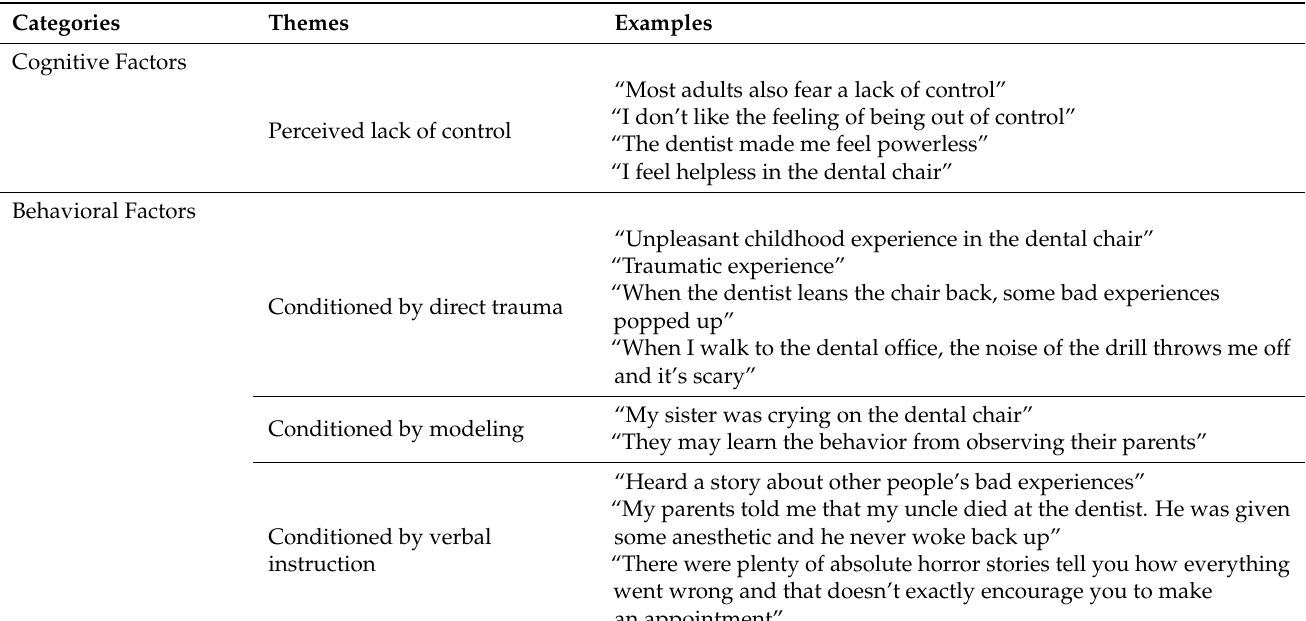
Table 4. Summary of etiology/cause of dental fear, dental anxiety, and dental phobia mentioned in the videos.